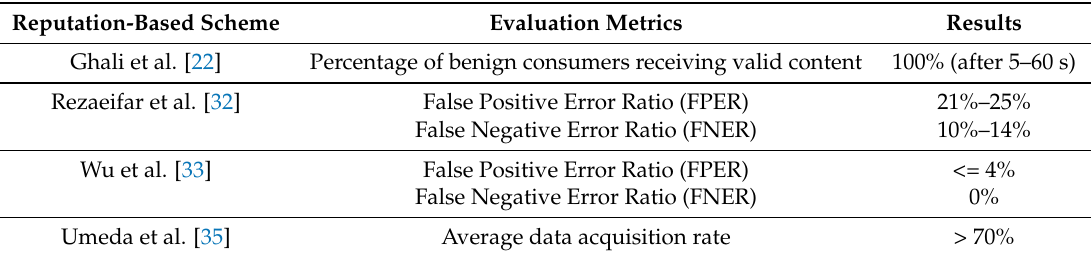
Table 1. Related work efficiency